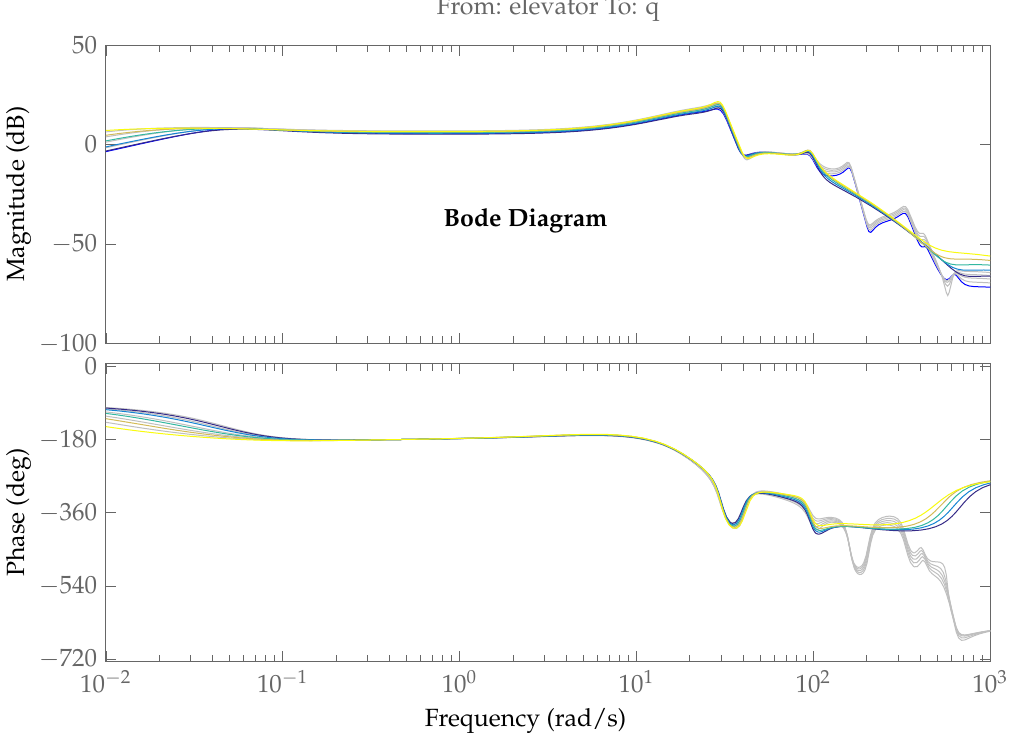
Figure 17. Frequency response of each ’bottom-up’ model compared to the full-order models at V = 22